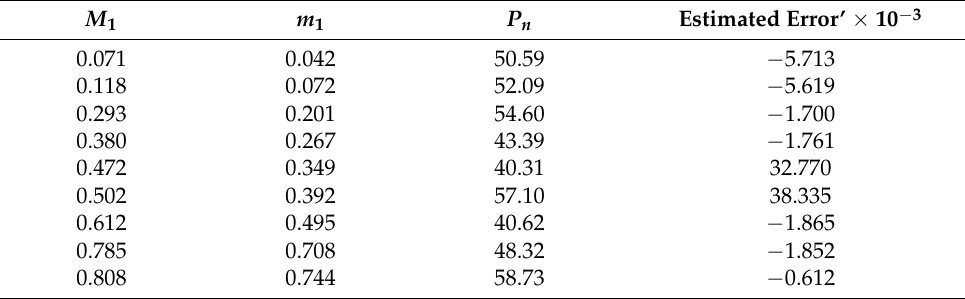
Table 11. The input data for high conversion and r 1 = 0.65 and r 2 = 2.12 (HC3).